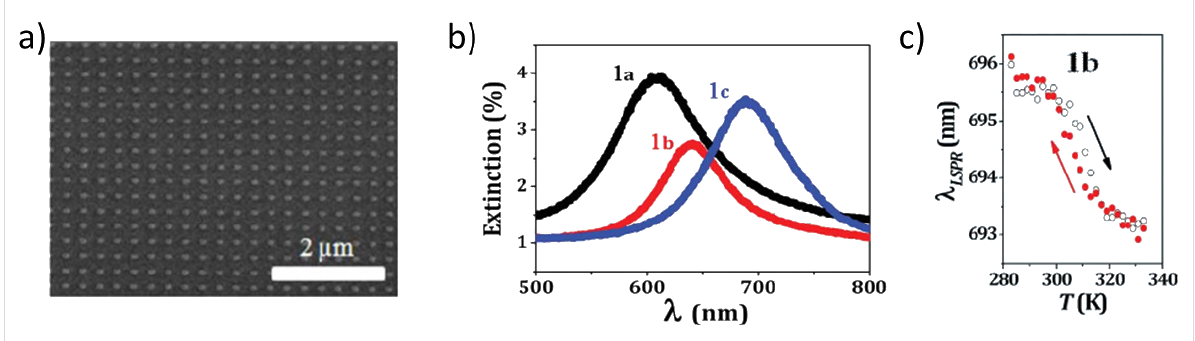
Figure 7: a) SEM image of a gold nanorod array with 200 nm pitch. b) Extinction spectra of three nanorod arrays with different aspect ratios. c) Plasmon resonance shift associated with the spin crossover of a 60 nm thin film deposited onto the nano-dot array displayed in a) as a function of temperature. Adapted with permission from [34], copyright 2013 The Royal Society of Chemistry.